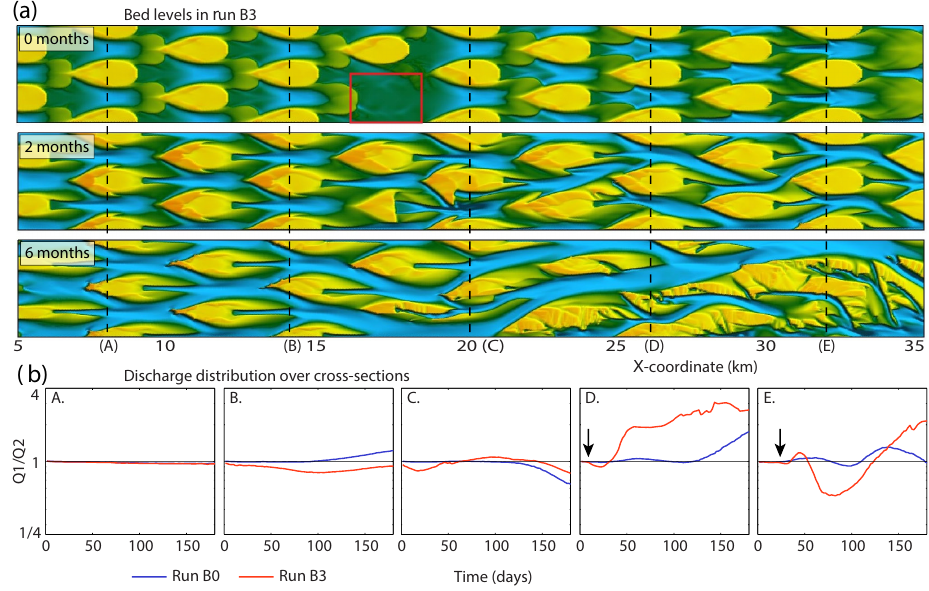
Figure 13. Evolution of the braided channel network and bar pattern in Run B3 with sand mining: (a) time series of the bed level and (b) discharge distribution with Q 1 the discharge through the northern branches. The black arrows indicate the position of the propagating